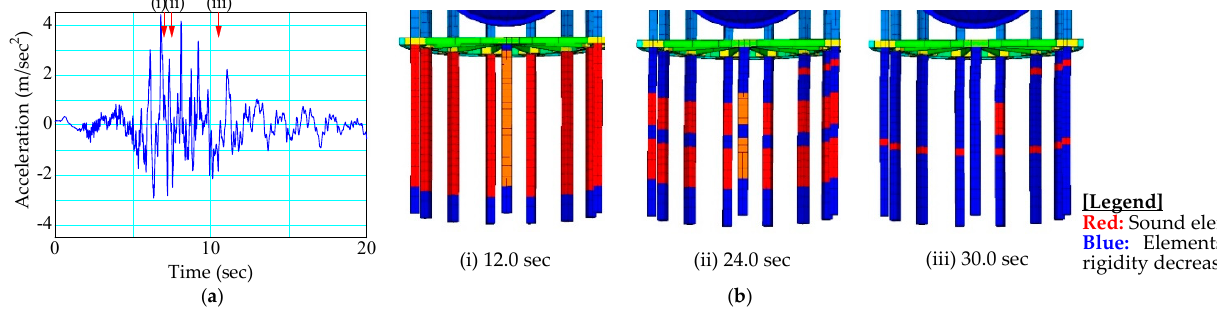
Figure 23. Progress of pile damage, seismic motion (B): ( a ) input seismic motion and damage time; ( b ) pile damage.